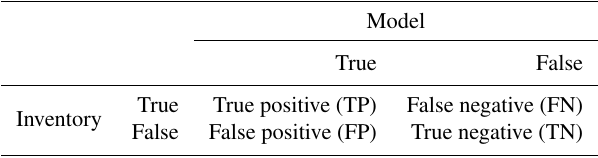
Table 4. The confusion matrix, resulting from the comparison of a reference Boolean raster and a raster corresponding to a